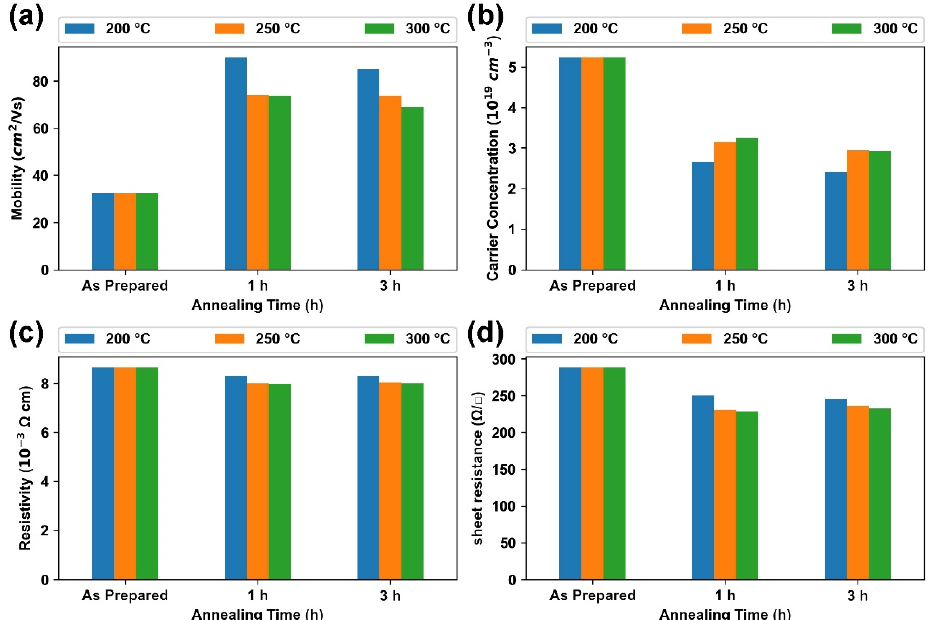
Figure 10. Electrical properties with annealing time: carrier mobility ( a ), carrier concentration ( b ), resistivity ( c ), and sheet resistance ( d ).